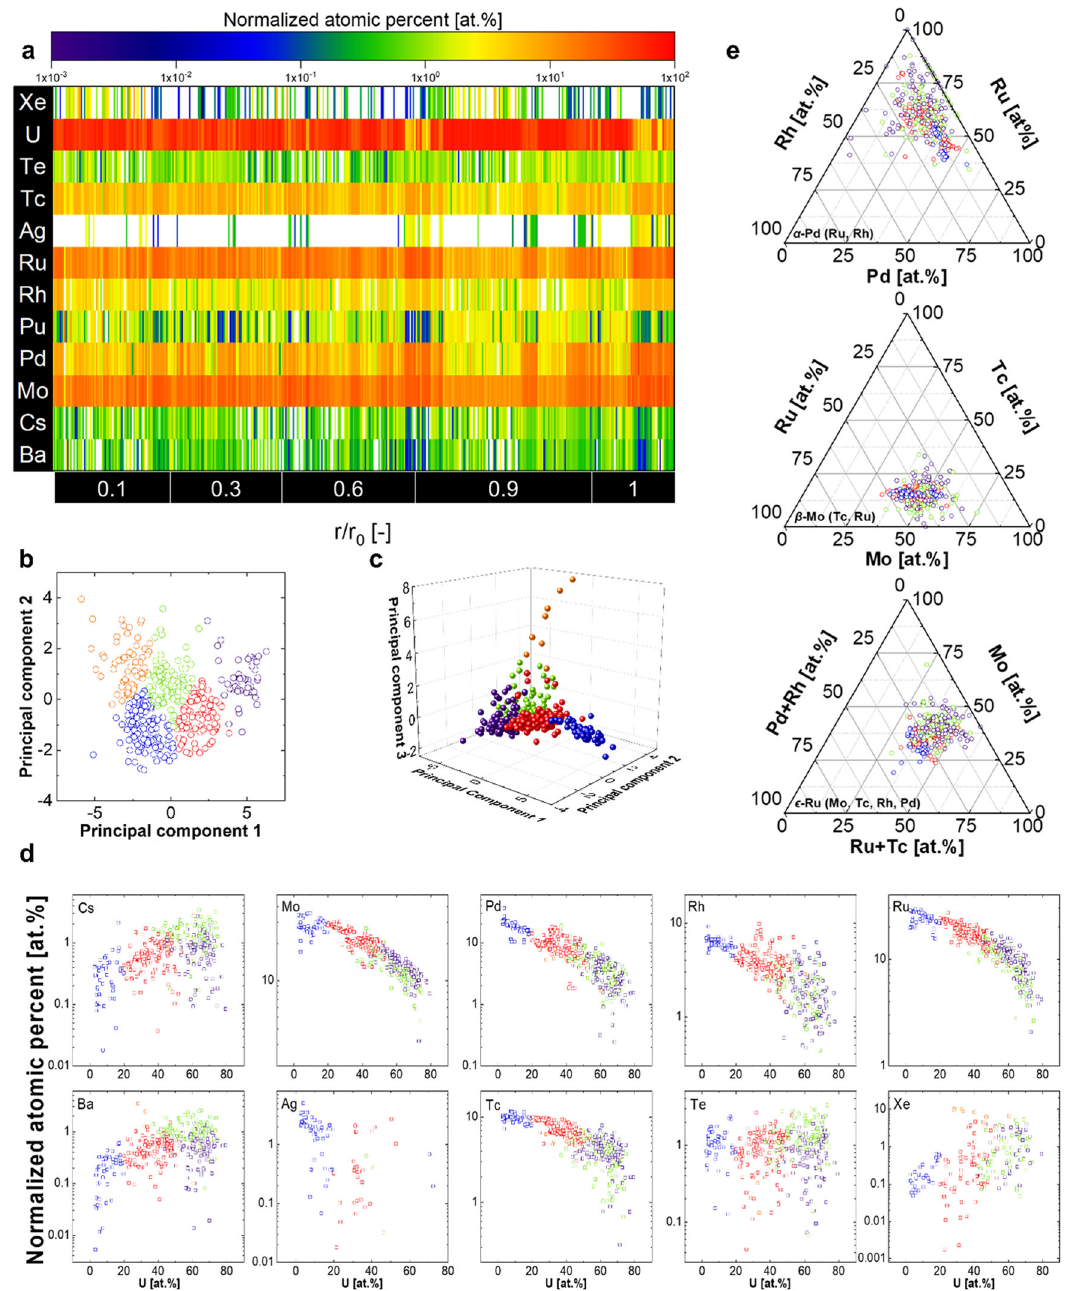
Fig. 6 Materials informatics – driven chemistry analysis on fi ssion-product metallic precipitates along the radial position. a Heatmap calculated from normalized at. % acquired from STEM-EDS maps and radial positions of the metallic precipitates in the Limerick fuel. Red indicates high levels of concentration, whereas blue and green indicate low levels of chemical concentration. The precipitates primarily consist of Mo, Tc, Ru, Rh, and Pd, with minor contributions from Ag. Te, Ba, Cs, and Xe are present as minor components. b k-means clustering based on two-component PCA decomposition. c k-means clustering based on three-component PCA decomposition. d Regression analysis after PCA. A strong correlation was found between the major fi ssion products (Mo, Tc, Ru, Rh, and Pd) and U. e Ternary phase diagram for three predicted fi ssion-product phases; individual metallic precipitate compositions were derived from clustering analysis of the STEM-EDS products at the nanoscale could explain the bimodal distribution of Xe bubbles 73 . (7) The decay product, such as Ba, could also Fig. 3c are accompanied by further segregation of the noble metal occur with the fi ssion fragments and gas, which could be a factor phases associated with Xe in Fig. 4b, c, indicating a nondiffusional that in fl uences the Xe redistribution. (8) The clustering analysis mechanism related to the heterogeneous model of the fi ssion shown in Fig. 6 illustrates that the variance in the phase com- fragments 70,71 . (5) The trapping of nanoscale Xe bubbles at the grain boundaries in Fig. 5 followed by growth into large pores position and structure of the metallic precipitates is related to the fi ssion products and Xe bubbles. (9) The Cs content is relatively could support the alternative recrystallization theory 72 . (6) The size-dependent resolution related to the segregation of fi ssion low across the radial positions because of its low solubility,